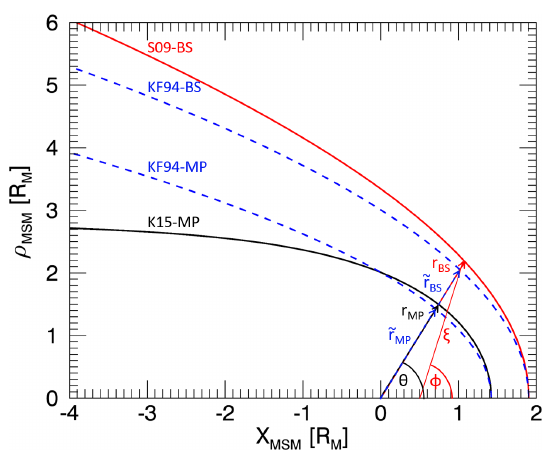
Figure 1. Schematic representation of the parameters used in the formulation of the bow shock and magnetopause in the MSM equa- torial plane. The solid red line is the bow shock evaluated from Eq. (2) (S09-BS; Slavin et al., 2009). The solid black line repre- sents the magnetopause determined by Eq. (3) (K15-MP; Korth et al., 2015). The dashed blue lines are the bow shock and magne- topause determined by Eq. (4) from the KF94 model (Kobel and Flückiger,